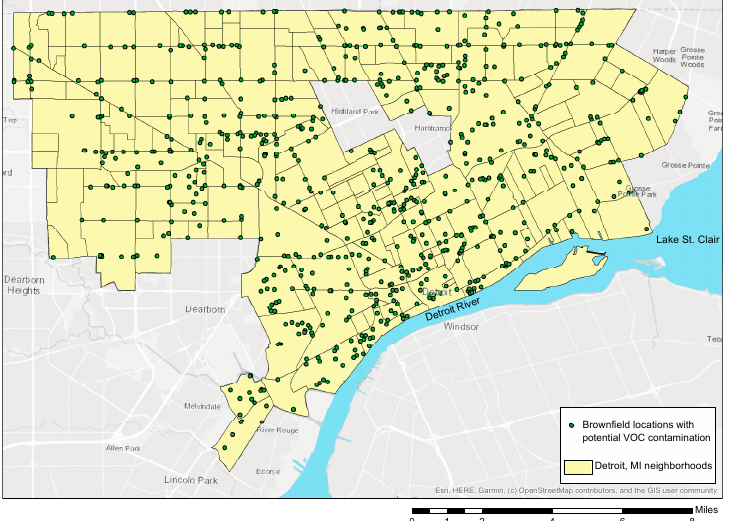
Figure 2. Detroit brownfield locations that can serve as sources of VOCs [68]. Note that Highland Park and Hamtramck are not part of the city of Detroit.